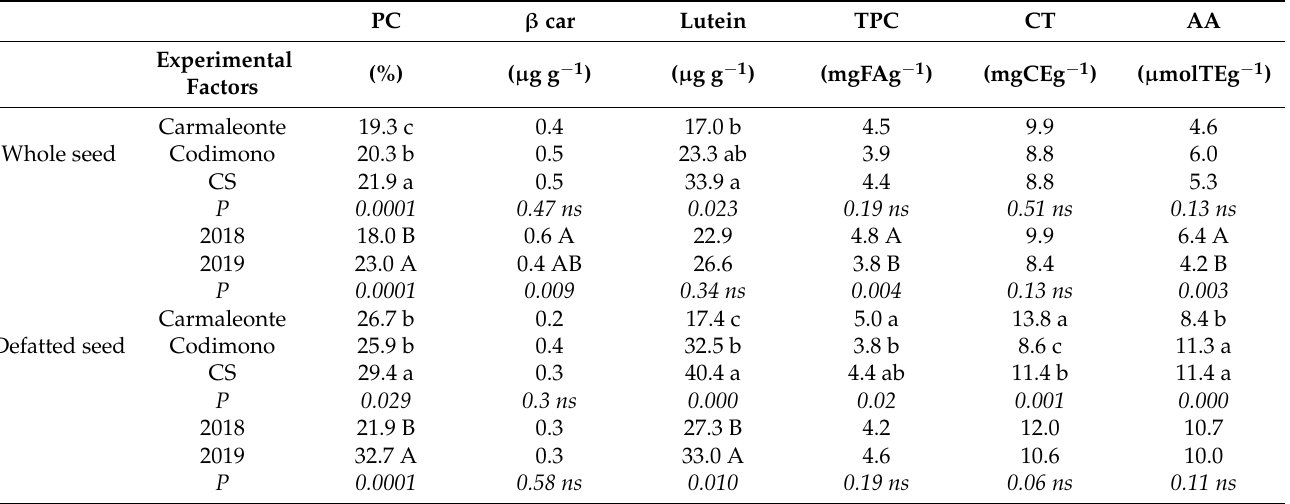
Table 2. Mean data with statistical significance for the experimental factors (genotype and year) on protein and phytochemical content of whole and defatted seeds of the three Italian hemp cultivars. PC β car Lutein TPC CT